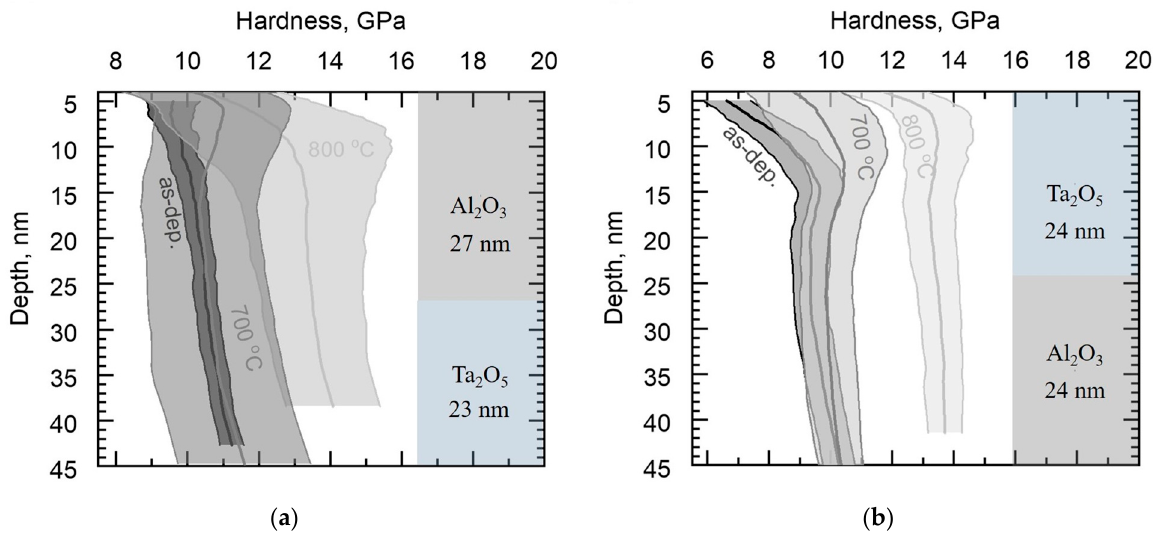
Figure 12. Average hardness along the fi lm depth, with standard deviation of the layered structure of the fi lm schematized on the right side of the panel: ( a ) as-deposited and annealed Al 2 O 3 /Ta 2 O 5 /Al 2 O 3 /Si; ( b ) as-deposited and annealed Ta 2 O 5 /Al 2 O 3 /Ta 2 O 5 /Si. Elastic moduli varied weakly along the depth of the fi lms. Moduli at 10 nm from the surfaces of Al 2 O 3 and Ta 2 O 5 fi lms deposited on silicon were ~155 and ~140 GPa (Figure 13),